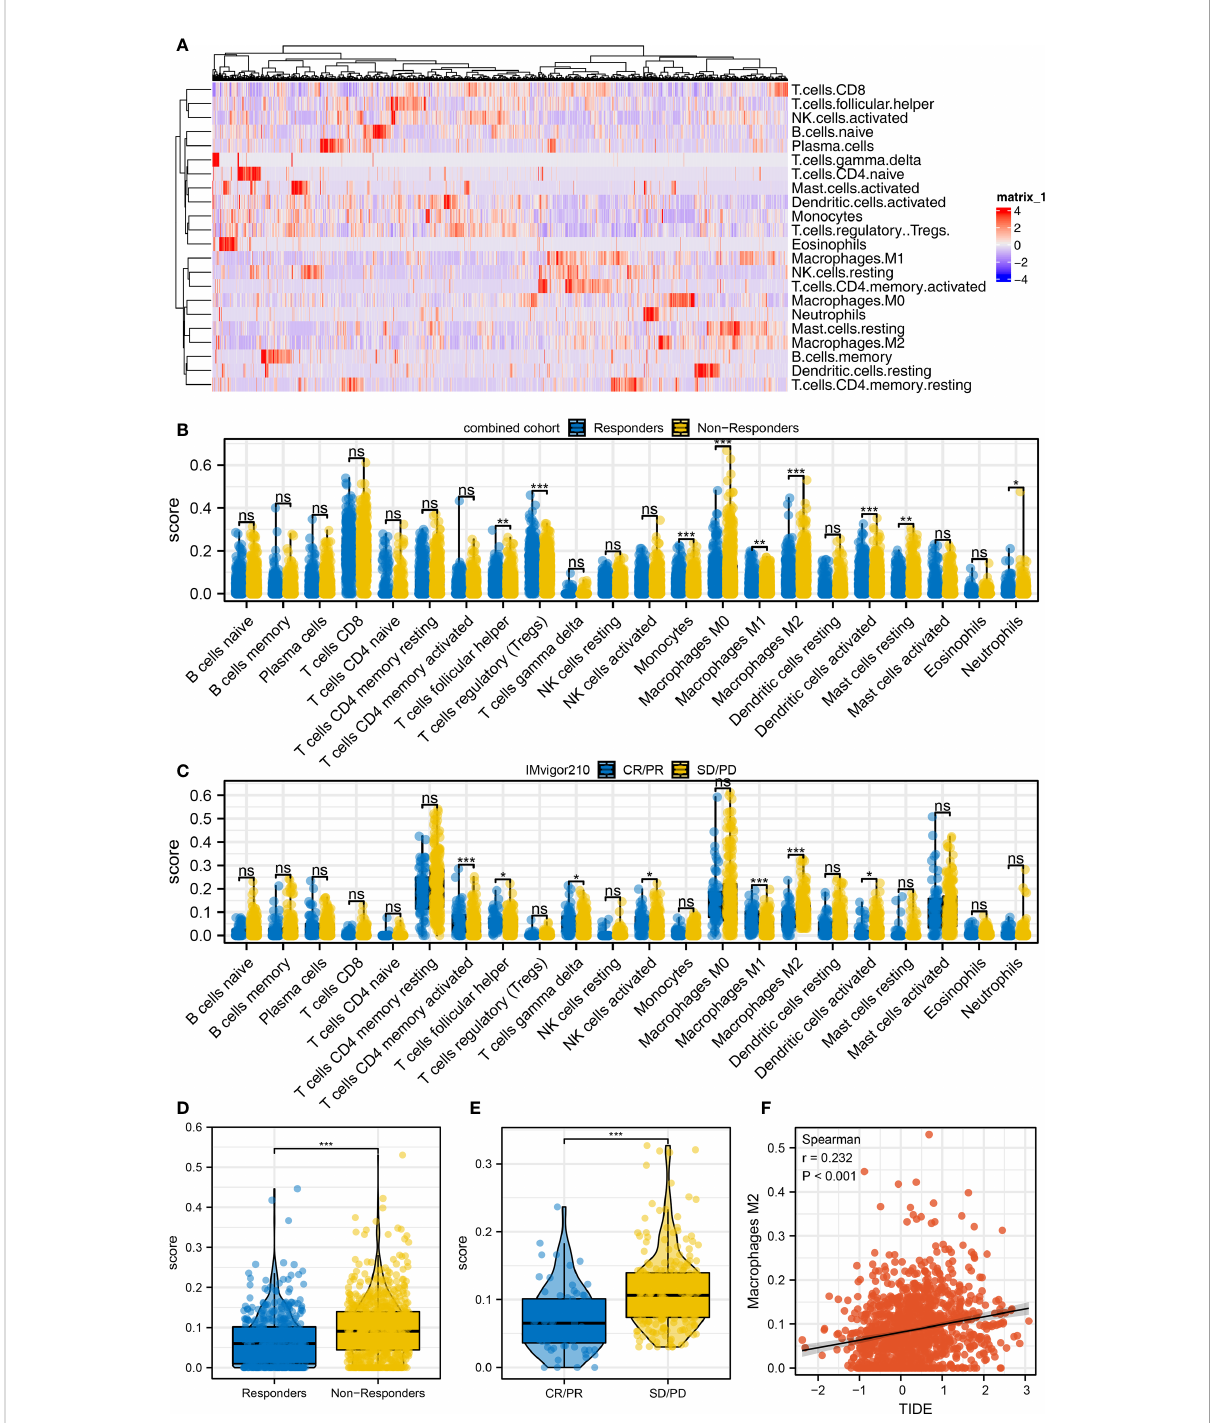
FIGURE 3 Immune microenvironment difference between immunotherapy responders and non-responders (A) The CIBERSORT algorithm was utilized to quantify the immune microenvironment of bladder cancer tissue. (B) The level of quanti fi ed immune cells in the immunotherapy responders and non-responders (combined cohort), ns = p > 0.05, * p < 0.05, ** p < 0.01, *** p < 0.001. (C) The level of quanti fi ed immune cells in the immunotherapy CR/PR and SD/PD patients (IMvigor210 cohort), ns = p > 0.05, * p < 0.05, ** p < 0.01, *** p < 0.001. (D) The level of M2 macrophage in immunotherapy responders and non-responders, *** p < 0.001. (E) The level of M2 macrophage in immunotherapy SD/PD and CR/PR patients, *** p < 0.001. (F) Correlation between the M2 macrophage and TIDE